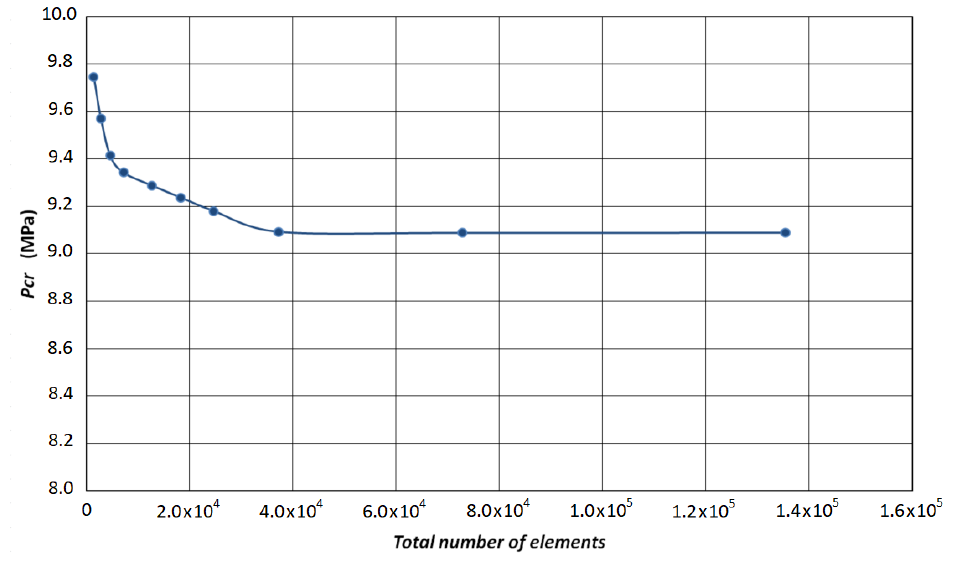
Figure 3. Convergence analysis for the unstiffened shell.